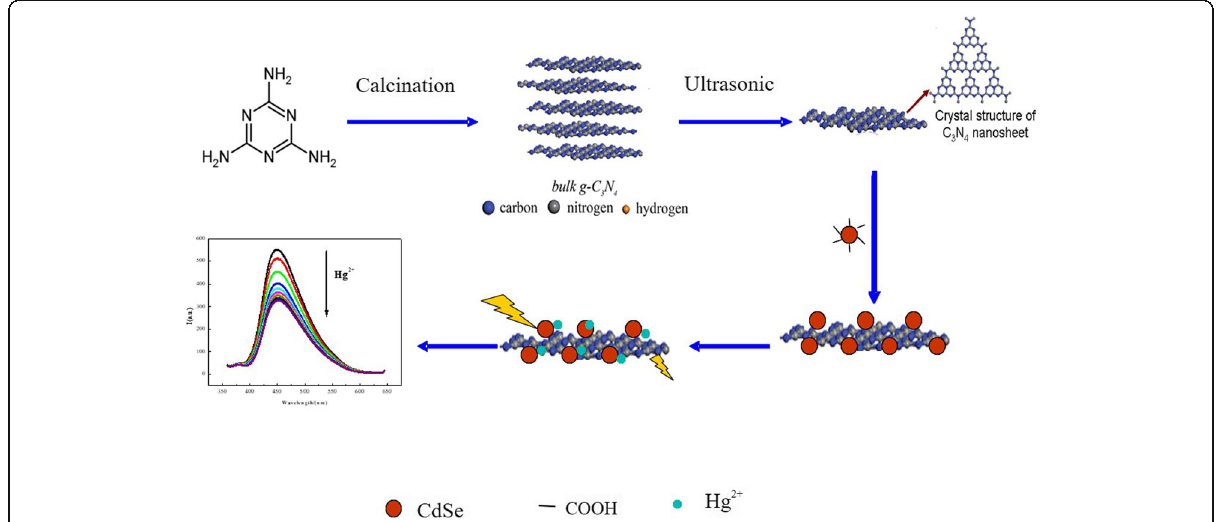
Fig. 1 The mechanisms of FRET-based detection for mercury